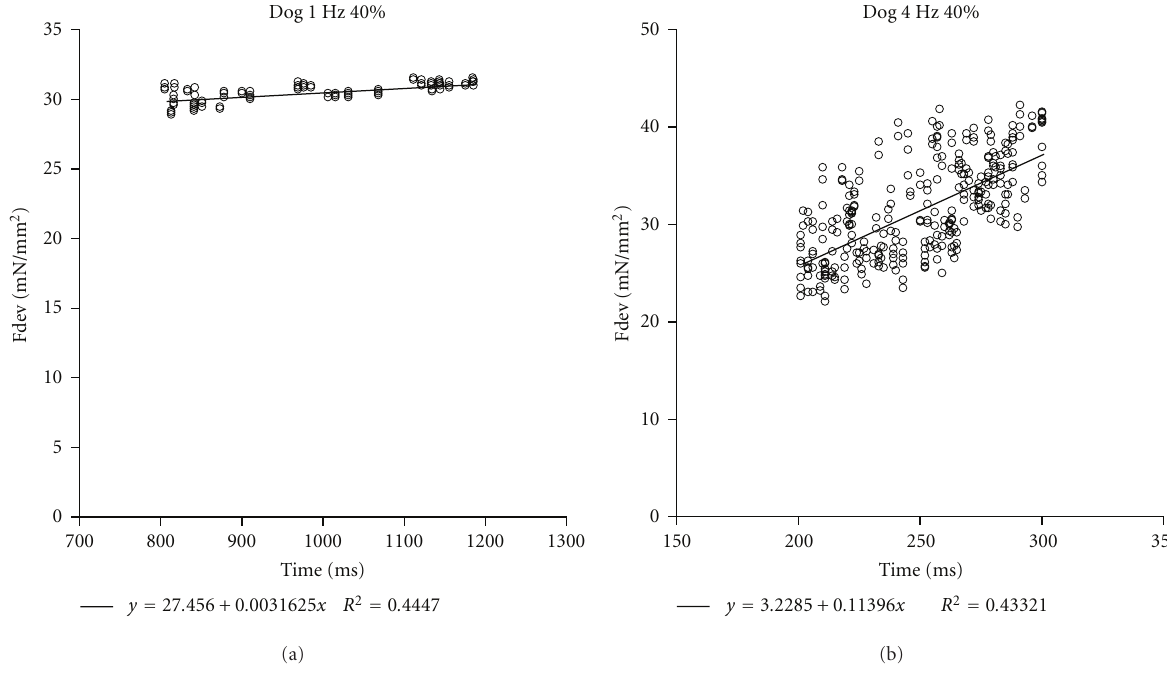
Figure 4: The correlation between prebeat duration and average force development in the dog is demonstrated for both 1 and 4Hz. There is no di ff erence with the increase in